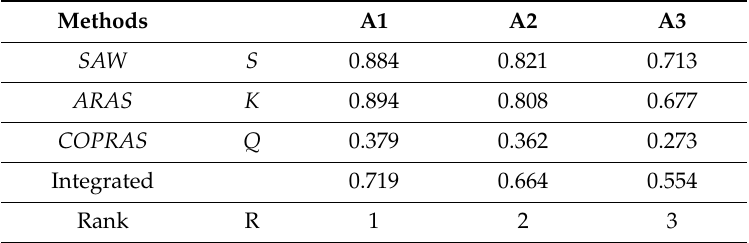
Table 10. Results of multi-criteria